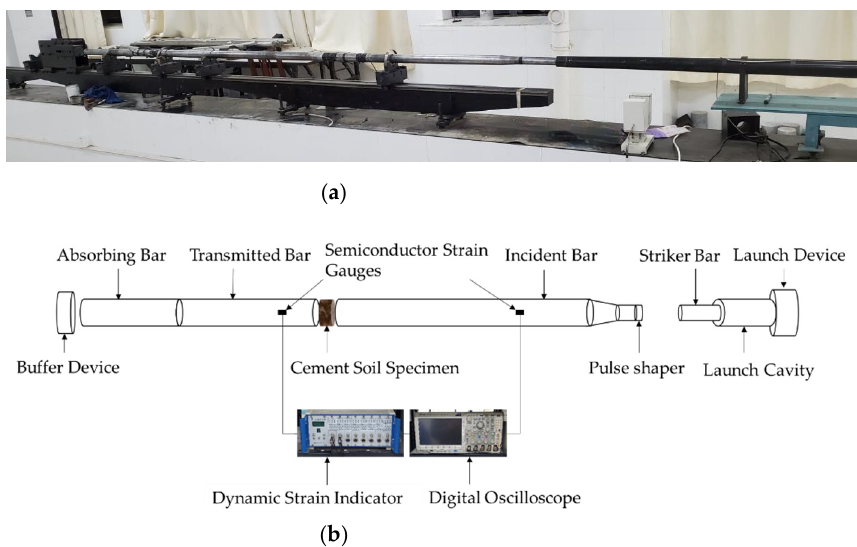
Figure 2. Split Hopkinson pressure bar test equipment: ( a ) picture of the split Hopkinson pressure bar and ( b ) schematic of the split Hopkinson pressure bar.